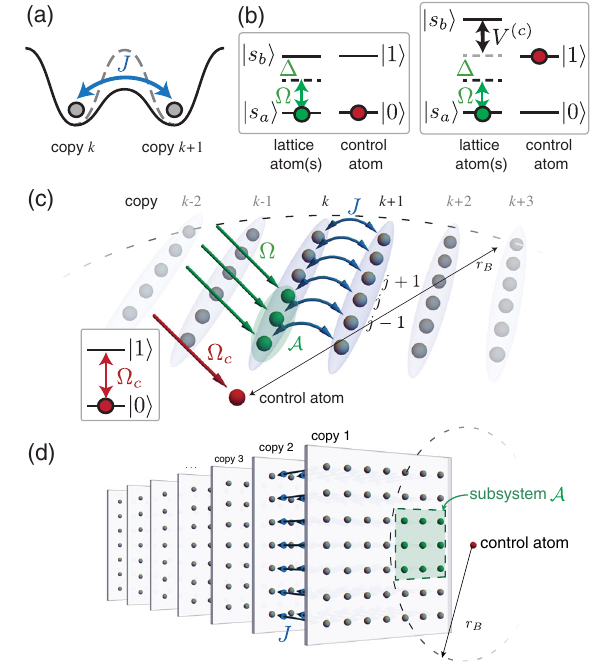
FIG. 2. Realization of the elementary operations of